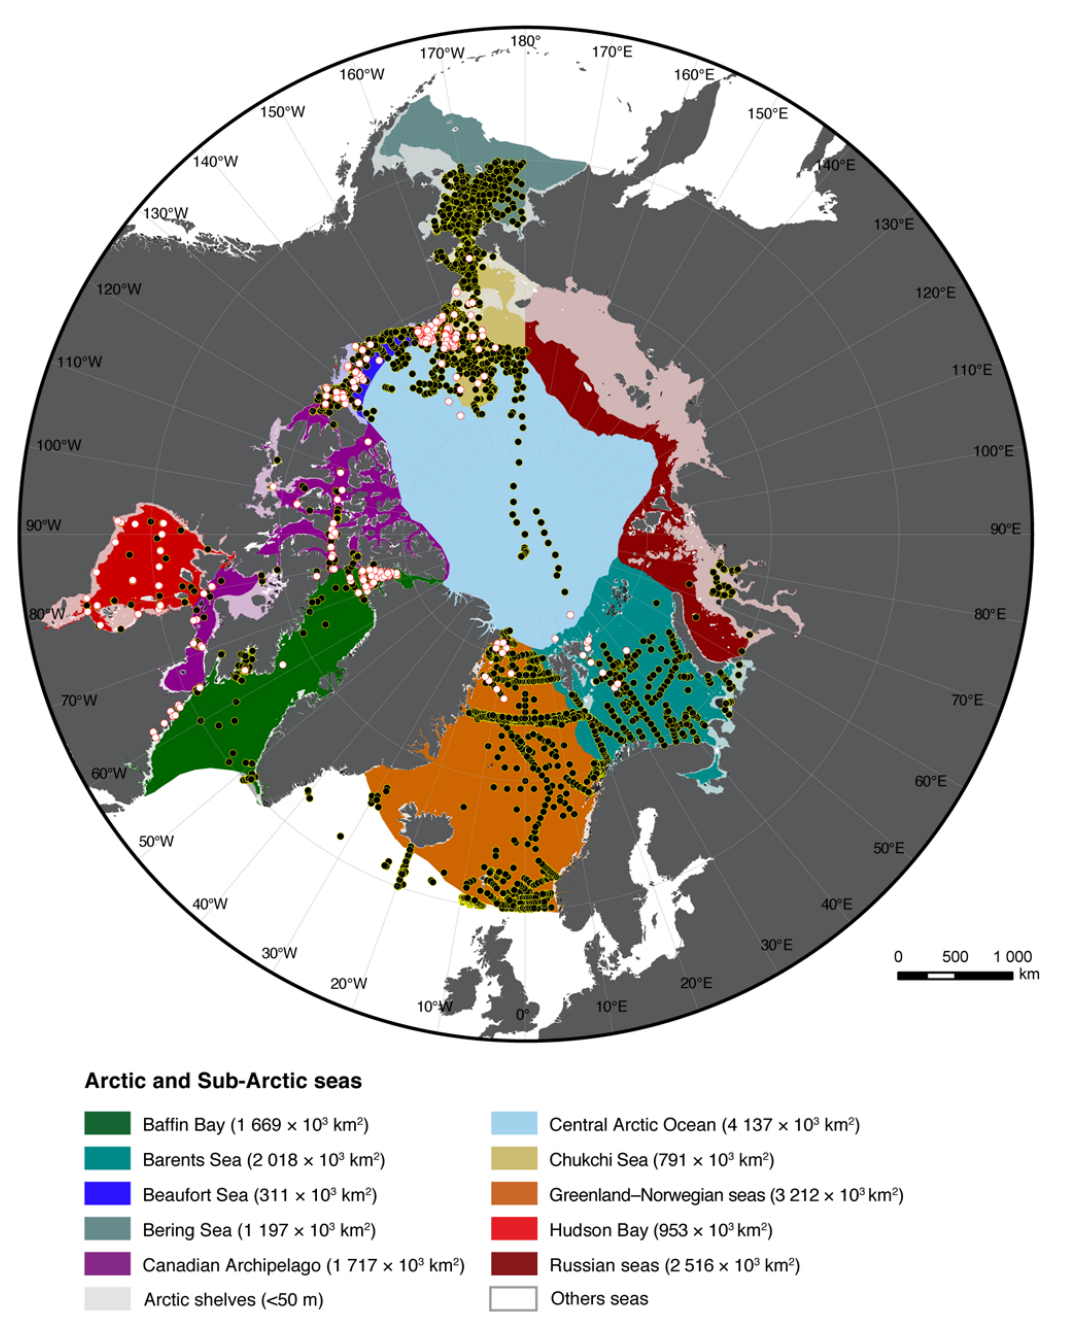
Fig. 1. Locations of the 5206 sampling stations for ( Figure 1: Locations of the 5206 sampling stations for ( Figure 1: Locations of the 5206 sampling stations for ( ) chlorophyll a and ( ) chlorophyll a and primary production in sub-Arctic and Arctic seas (map adapted from Spalding et al. (2007) and the WWF agency) and shelves (≤50 m). The area of each sub- Arctic and Arctic sea is also